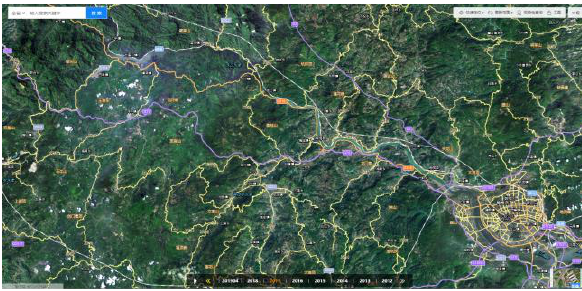
Figure1 . Multi-temporal image service of Fujian node Also as a sub-node of TIANDITU, Shandong's multi-temporal image service provides richer data content and more functions.